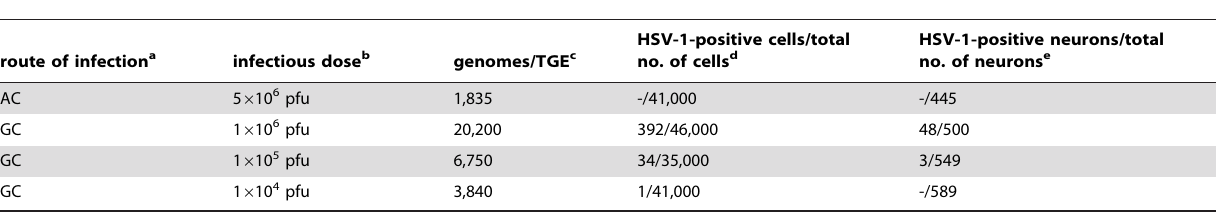
Table 1. Detection of primary infected cells in dispersed TGEs at 2